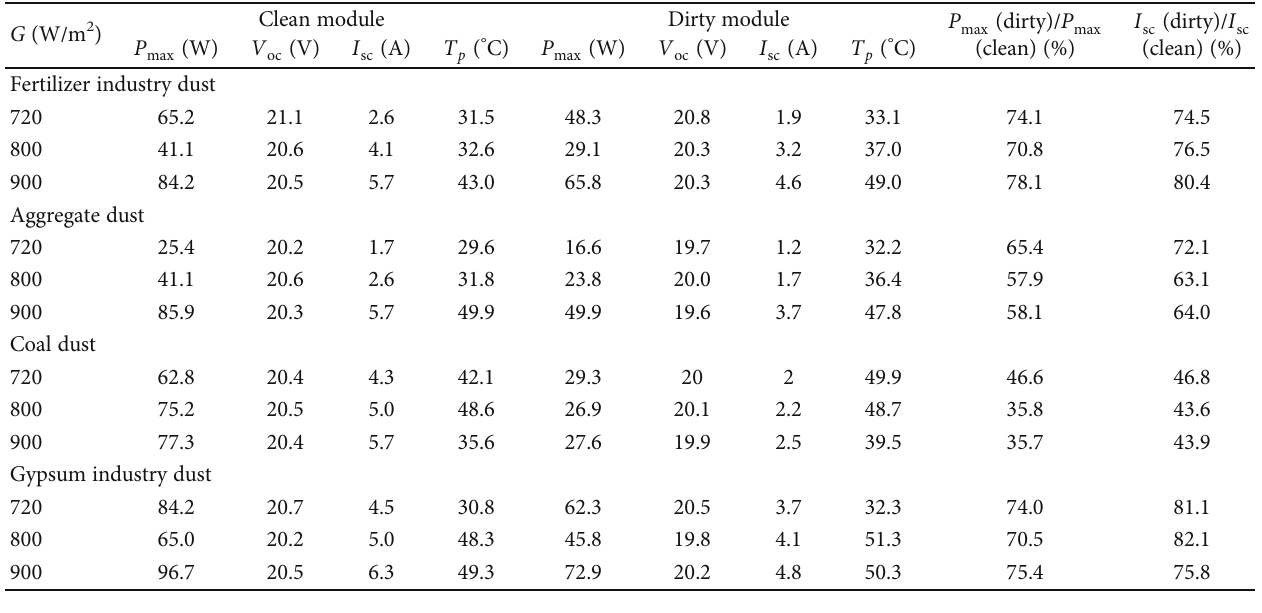
I V Table 3: P max , sc , and oc for clean and dirty modules under